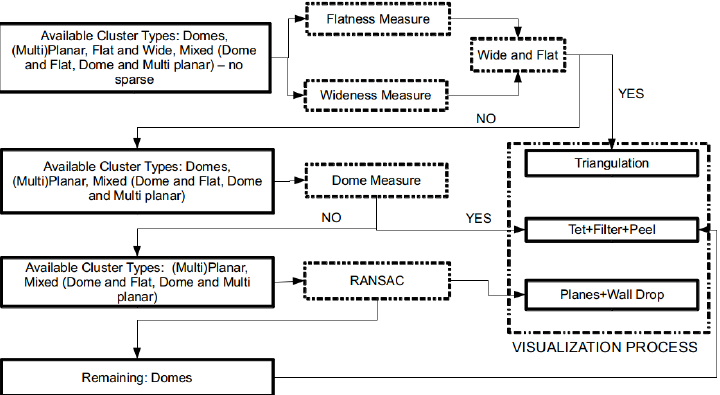
Figure 2: Schema for the processing of clusters